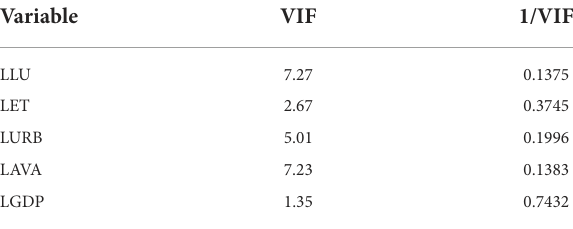
Table A1 VIF test for